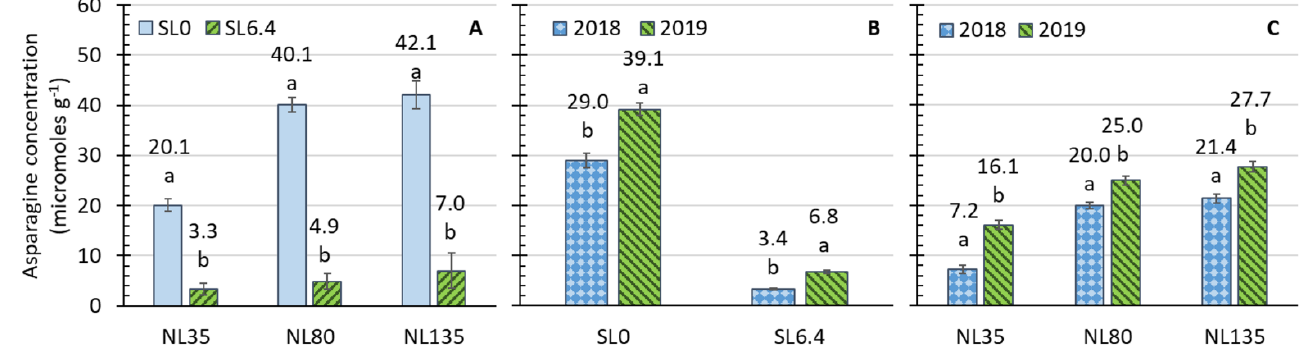
Figure 5. Interactions between years and agronomic treatments on asparagine content in grain; ( A ) Effect of nitrogen fertilization level (NL) and sulfur fertilization level (SL); ( B ) effect of year (Y) and sulfur fertilization level (SL); ( C ) effect of the year (Y) and nitrogen fertilization (NL). Lowercase letters represent the Tukey HSD post hoc test results.